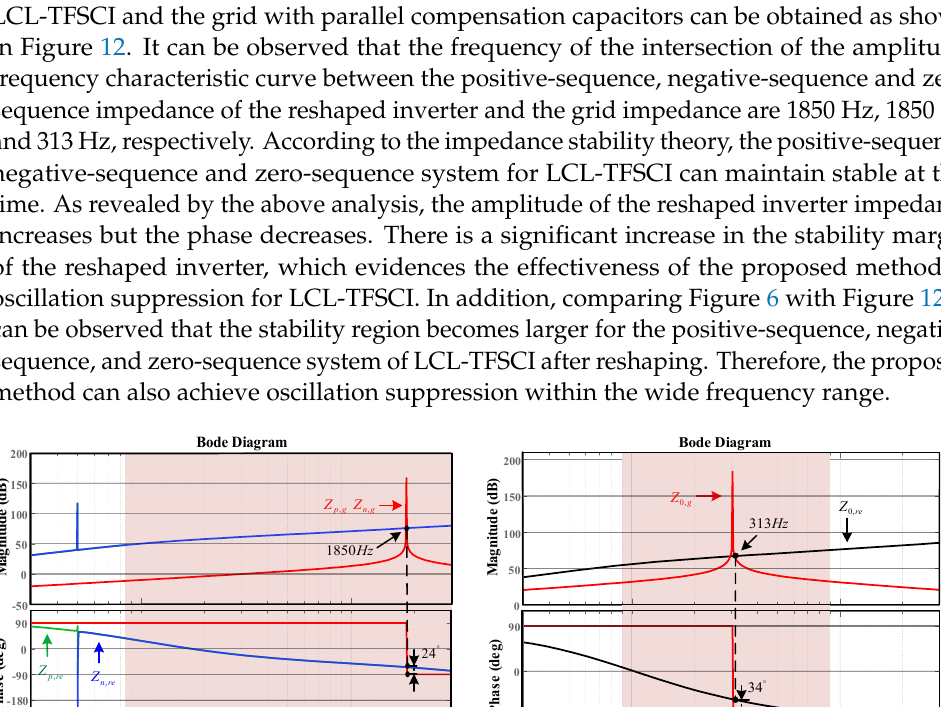
Figure 13. Bode diagram for the zero-sequence impedance of LCL-TFSCI and grid impedance when different k is applied. Figure 14 shows Bode diagram for the zero-sequence impedance of LCL-TFSCI and grid impedance when different C g is applied. The analysis reveals that the proposed oscil- lation-suppression method remains capable to ensure the large stability margin of LCL- TFSCI when the parallel compensation capacitors C g vary. The risk of system oscillation instability is significantly reduced, thus demonstrating that the proposed method is still highly adaptable with C g changing.